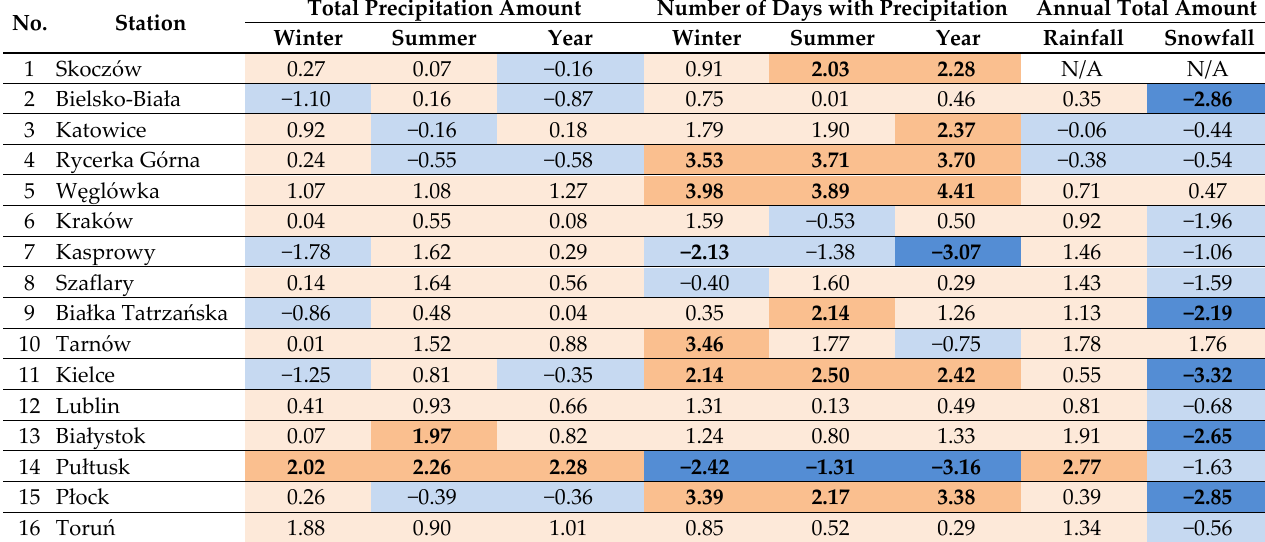
Table 9. Results of the Mann test ( uF statistics) for trends in precipitation characteristics in the seasonal and annual time scales; orange colour denotes positive uF values, blue colour negative. Numbers in bold indicate statistically significant changes at α level 0.05.